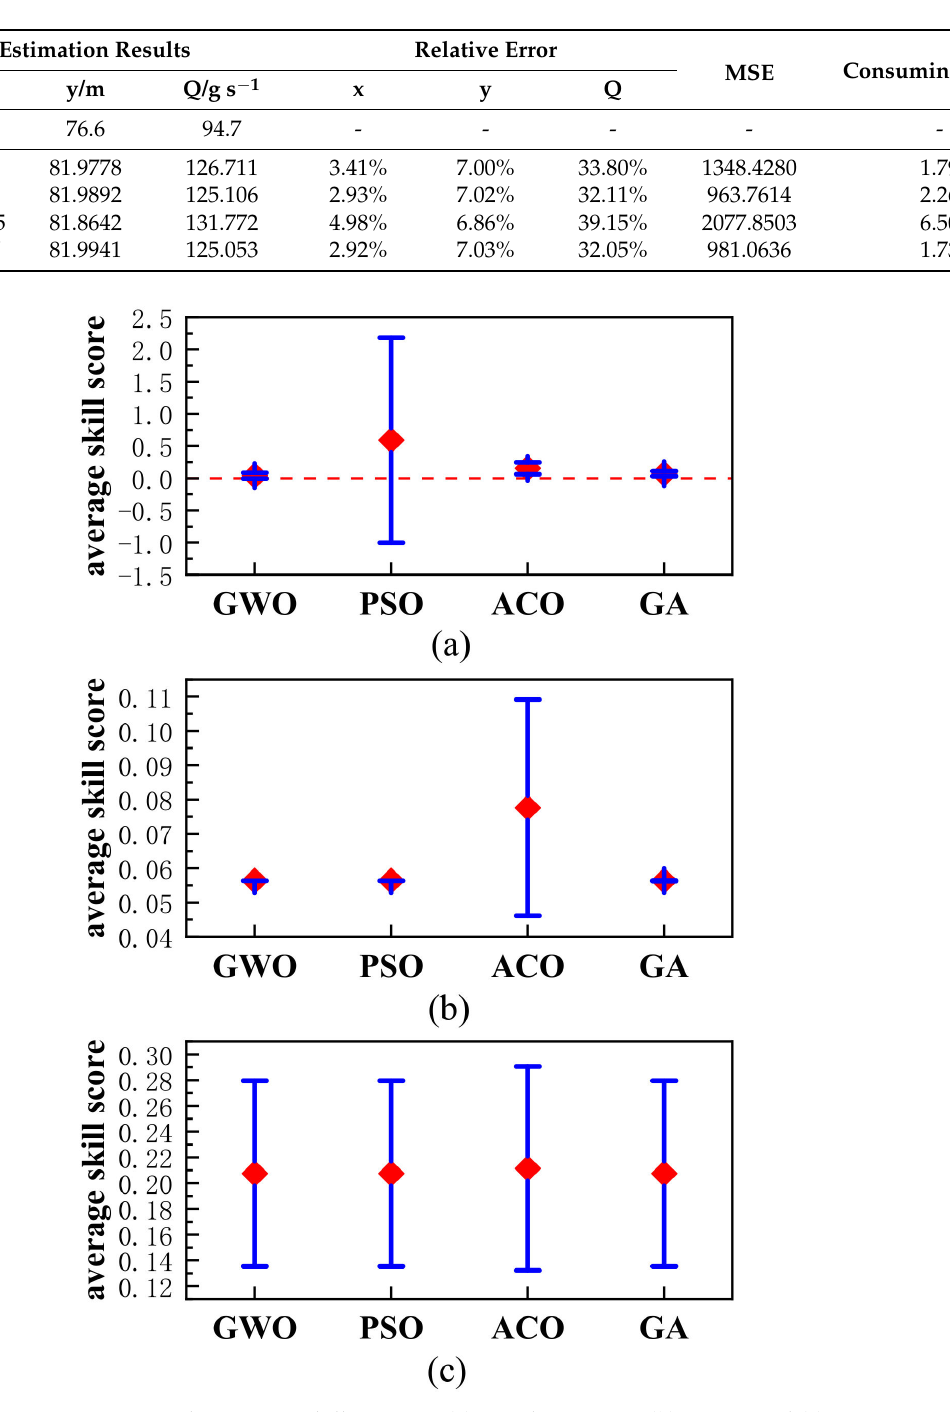
Figure 4. The average skill scores in ( a ) simulation case, ( b ) run 17 and ( c ) run 33, represented by mean values (red diamond) and standard deviation (blue error